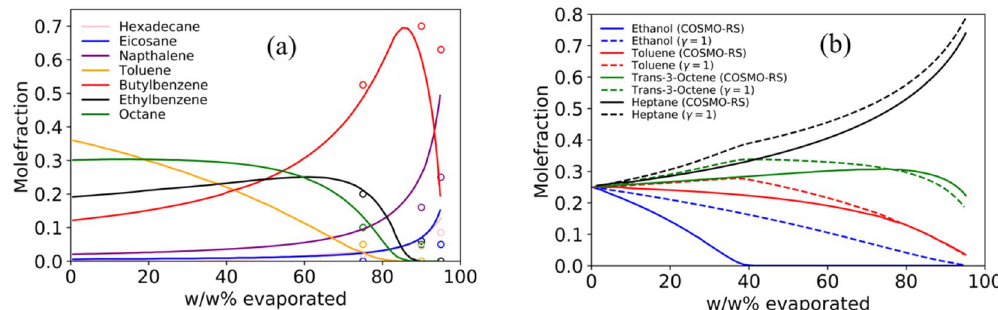
Figure 2. Effect of weathering degree (i.e., % evaporated) and activity coefficients on the composition change of synthetic gasoline-like samples. ( a ) Composition change of a seven component (hexadecane, eicosane, naphthalene, toluene, butylbenzene, ethylbenzene, and octane) synthetic nonpolar gasoline mixture as a function of the degree of weathering at 298.15 K. Lines are modeling results and symbols are experimental data. Note that the activity coefficients have a small effect on the evaporation behavior of this nonpolar mixture (the lines of γ = 1 coincide with the lines computed from COSMO-RS). ( b ) The effect of activity coefficients on